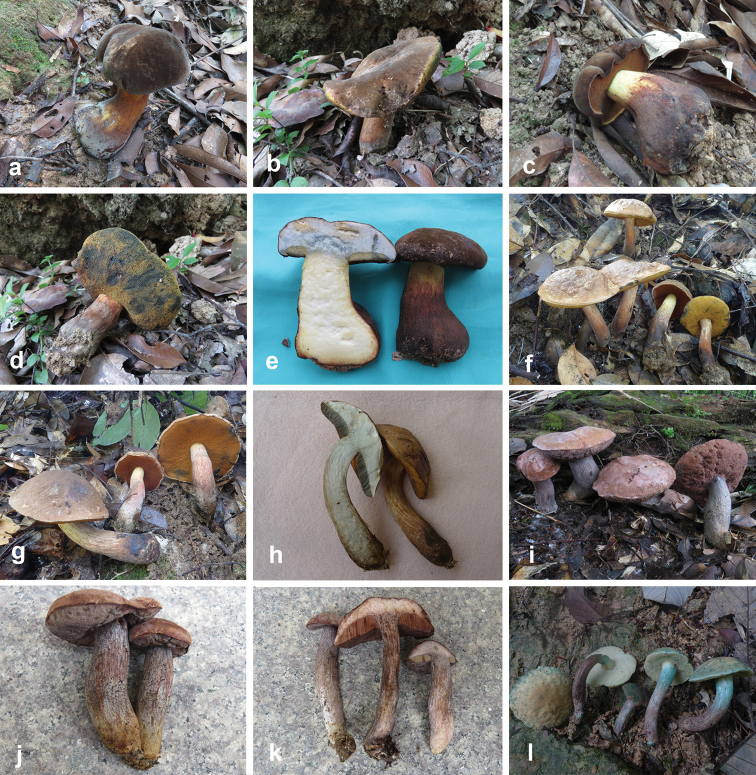

Basidiomata of boletes. a–eNeoboletusobscureumbrinus (a, e from FHMU 2271 b, d from FHMU 2055 c from FHMU 2814) f–hNeoboletustomentulosus (h–i from FHMU 842, j from FHMU 841) i–kSutoriussubrufus (FHMU 2004, holotype) lTylopilusvirescens (FHMU 1004). Photos by N.K. Zeng.